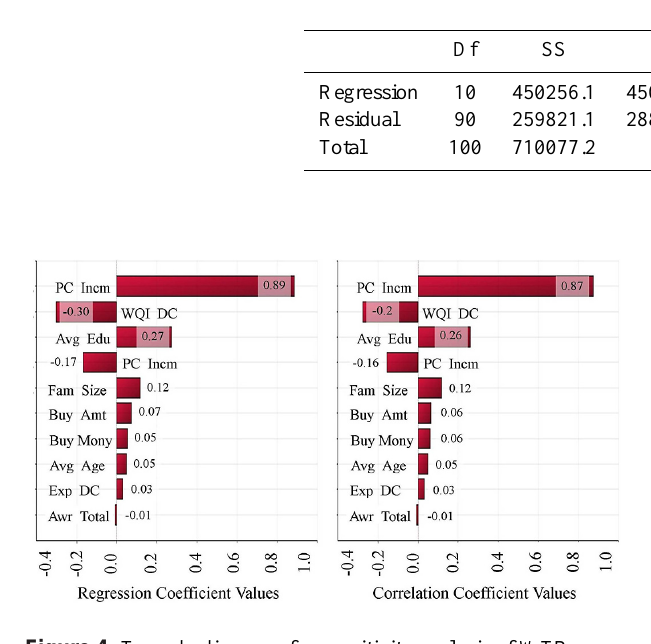
Table 8. ANOVA for multiple regression.